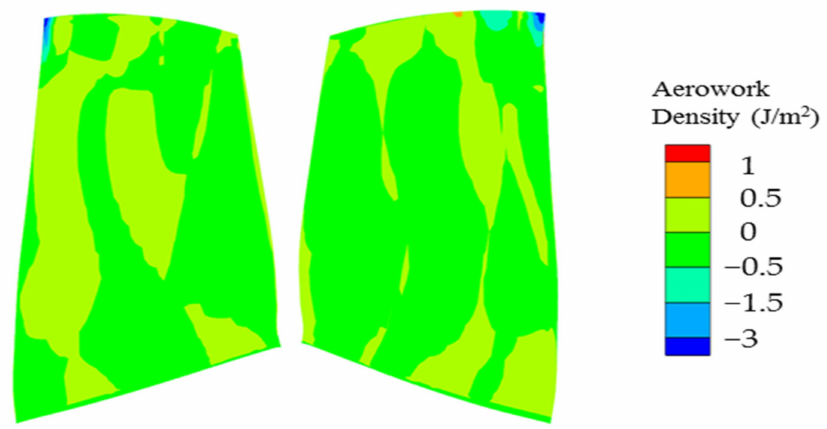
Figure 17. Aerowork density distribution on blade surface for ND = 3